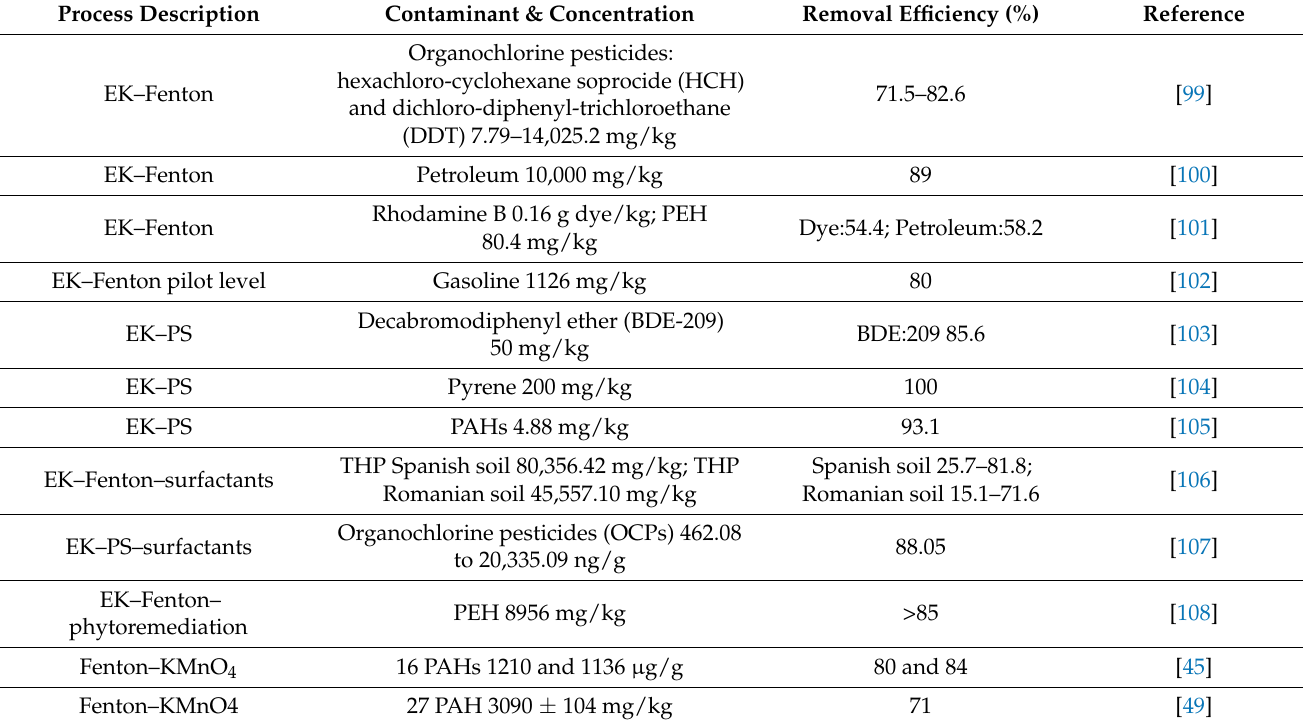
Table 3. Recently published articles on soil decontamination by coupled